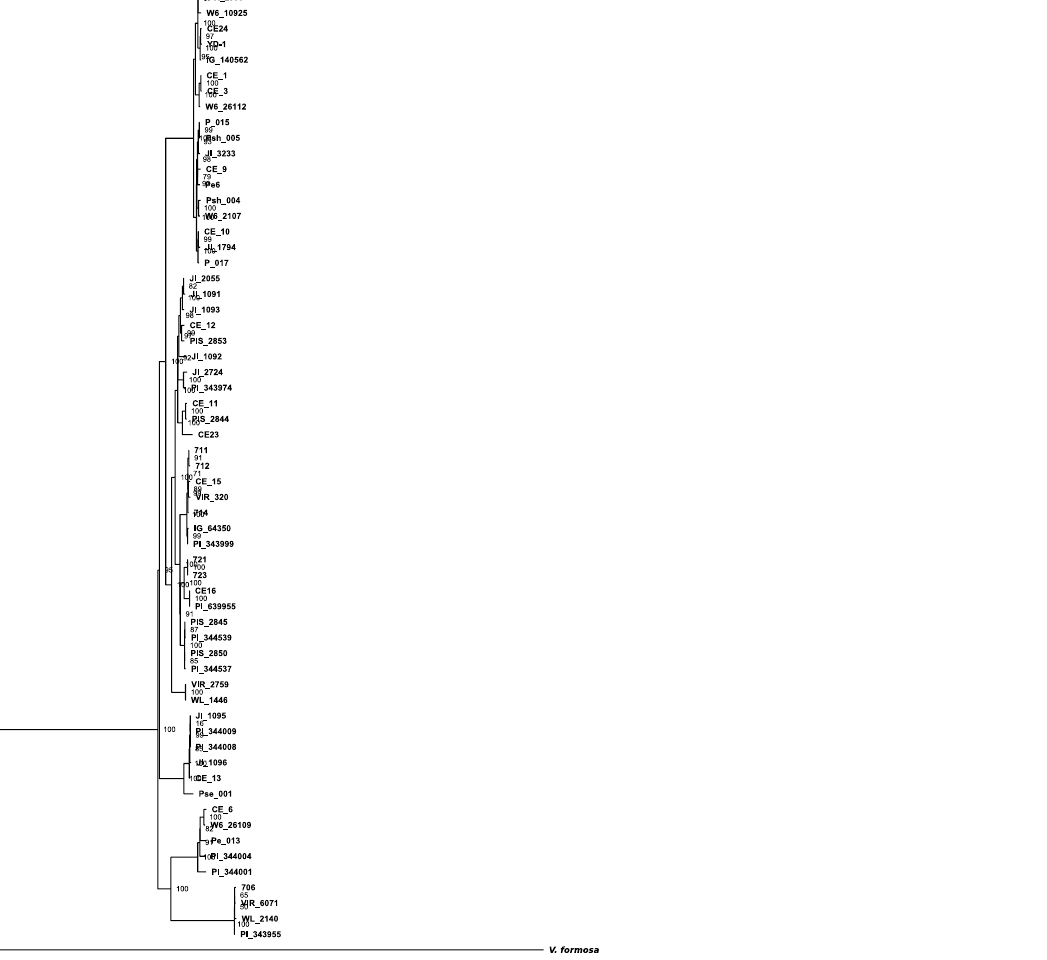
Figure 3. Phylogenetic tree of the studied pea accessions reconstructed on the basis of the plastid genomes using Maximum Likelihood method. Bootstrap support values of the nodes are indicated. Scale bar corresponds to the number of nucleotide substitutions per site.